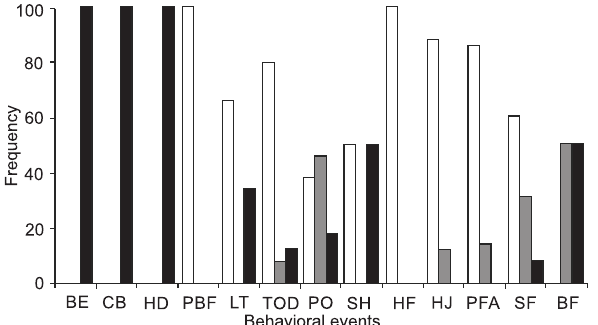
Figure 1. Frequency of occurrence for each event in the three be- havioral states. (HJ) Horizontal jump, (PFA) partial flop ahead, (PO) porpoising, (SF) side flop, (PBF) partial back flop, (LT) Lobtail, (TOD) tail out dive, (SH) spy-hopping, (CB) club, (HD) heading, (HF) head flop, (BE) belly exposure, (BF) back flop, ( (cid:133) ) feeding, ( (cid:132) ) travelling, ( (cid:132) ) socio-sexual.